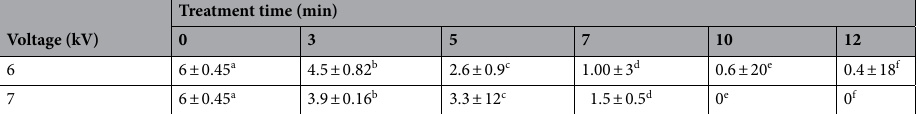
Table 4. The number of E. coli cells (Log CFU/gr) after the cold plasma treatment. The Saffron is treated by cold plasma at different times (0, 3, 5, 7, 10, and 12 min) and at different voltages (6 and 7 kV). The number of E. coli was enumerated after treatment. abcdef means in the same row followed by different superscript letters are significantly different ( P < 0.05). Data represent the mean ± standard deviation of each sample (n = 3).